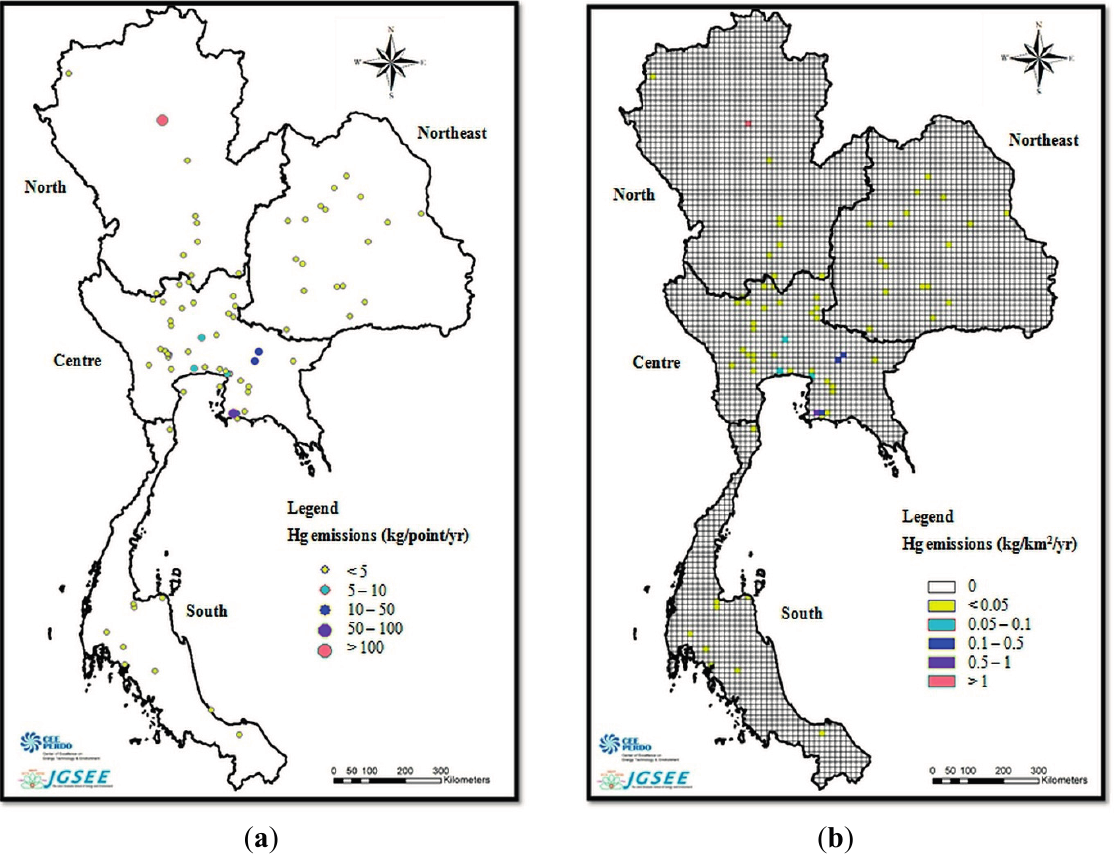
Figure 3. ( a ) A-Point-Sources-Map of Atmospheric Hg Emissions in Thailand; ( b ) A-0.1-Degree-Gridded-Map of Atmospheric Hg Emissions in